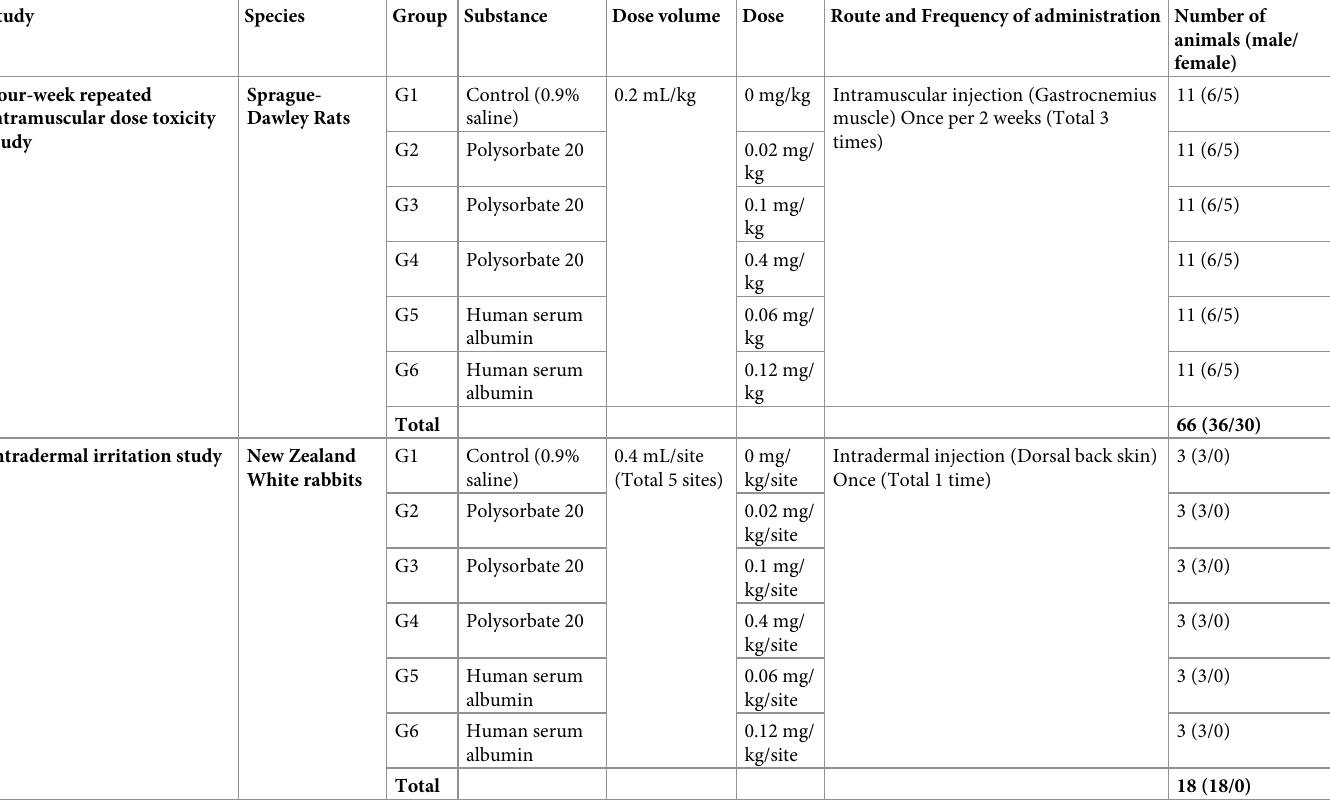
animals (male/ female)